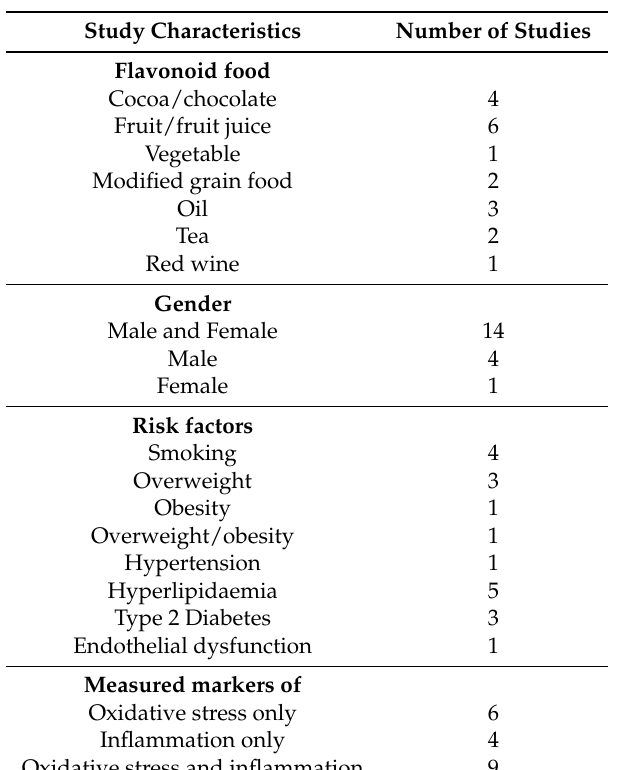
Table 1. Heterogeneity of studies meeting studies meeting the inclusion